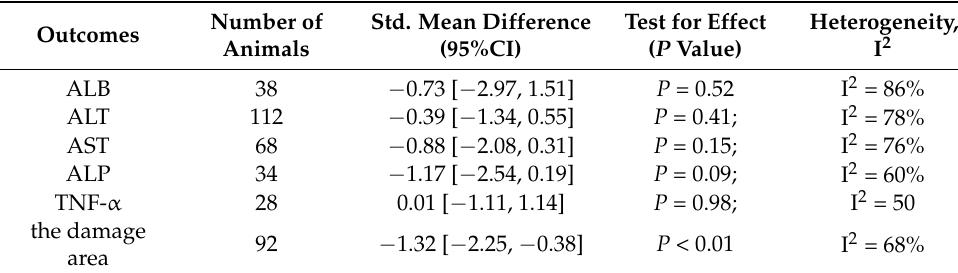
Table 3. Comparing the efficacy of MSC-EV therapy with MSCs